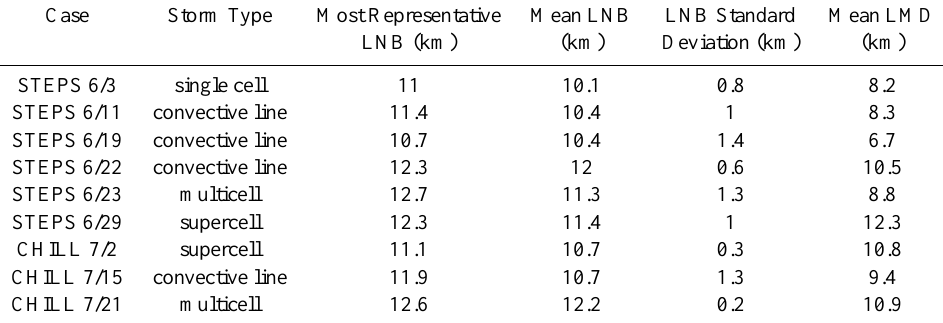
Table 1. Summary of detrainment analysis for each case. Most representative level of neutral buoyancy (LNB) is calculated from the central NARR simulated sounding; mature level of maximum detrainment (LMD) is calculated by taking the mean LMD during the mature stage of the observed storm. The mean and standard deviation calculations for LNB include all non-zero methods from all collected soundings (e.g. see Table 2 for LNB calculations for STEPS 6/29 case). All STEPS cases are from 2000; all CHILL cases are from 1998. All altitudes are given as